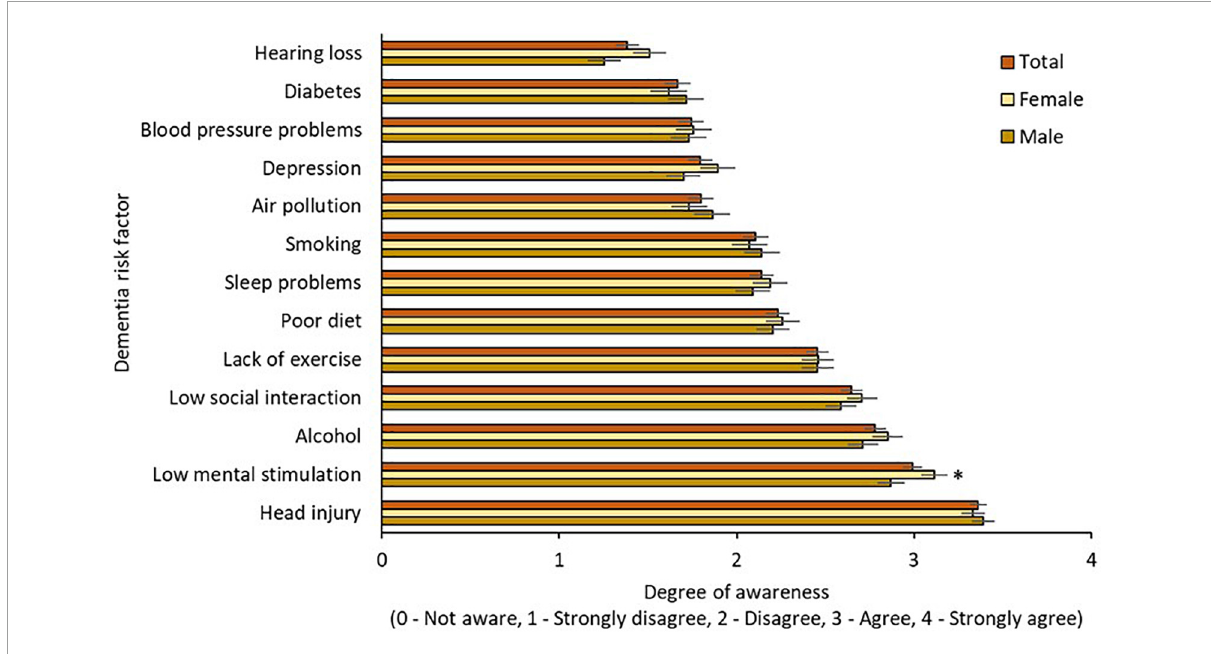
FIGURE2 Awareness of modifiable risk factors by gender. ∗ = sig. different from male group at 0.05 level.